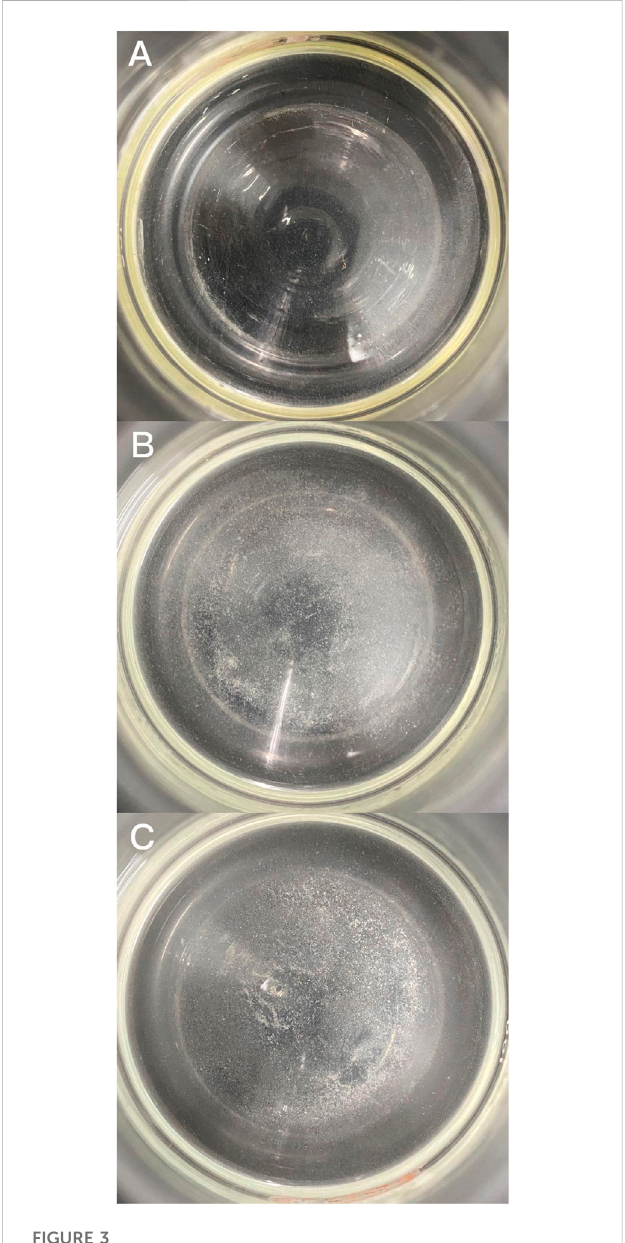
Photos of reactors (A) A1, (B) B1, and (C)